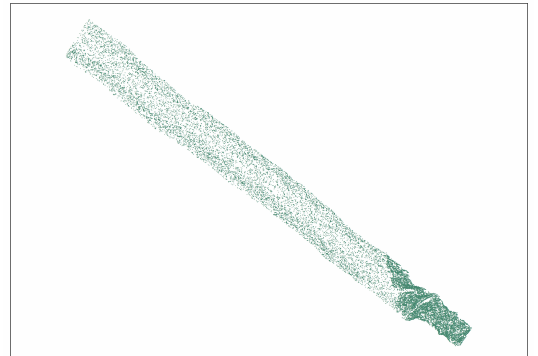
Figure 12. System-based thinning method of 5% thinning rate